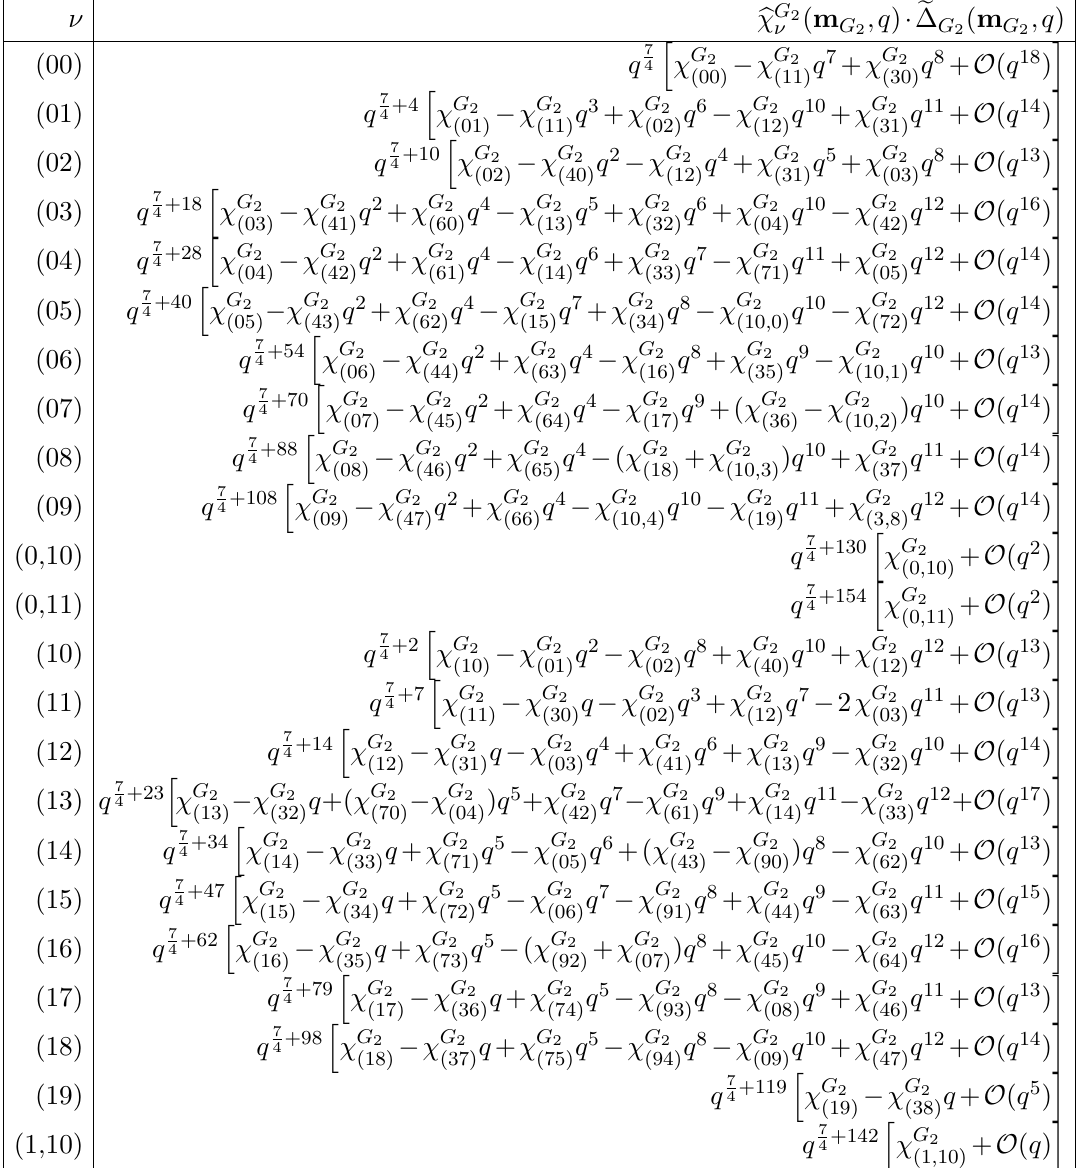
Table 19. Irreducible level (cid:0) 3 characters of G 2 (rescaled by an overall factor of e (cid:1) G a set of highest-weight representations that contribute to the elliptic genus. The expansion is given to an order su(cid:14)cient to compute the elliptic genus to O ( q 13 ) and O ( v 22 ).